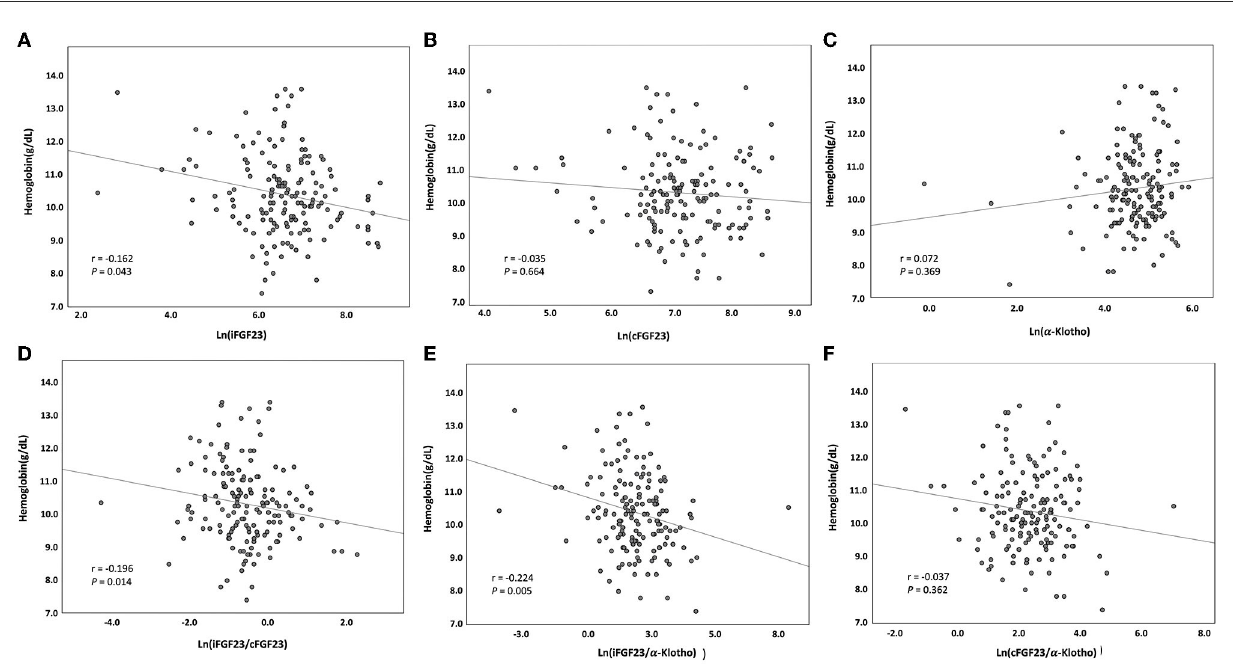
FIGURE2 Serum hemoglobin level vs. serum (A) ln(iFGF23), (B) ln(cFGF23), (C) ln( α -klotho), (D) ln(iFGF23/cFGF23), (E) ln(iFGF23/ α -klotho), and (F) ln(cFGF23/ α -klotho) levels. The lines indicate best-fit regression lines derived using the least mean square